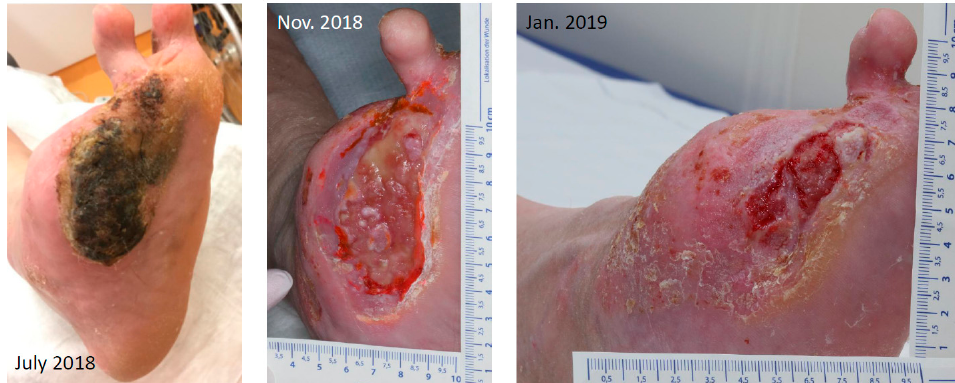
Figure 6. Pre- and postoperative clinical findings in Case 1.